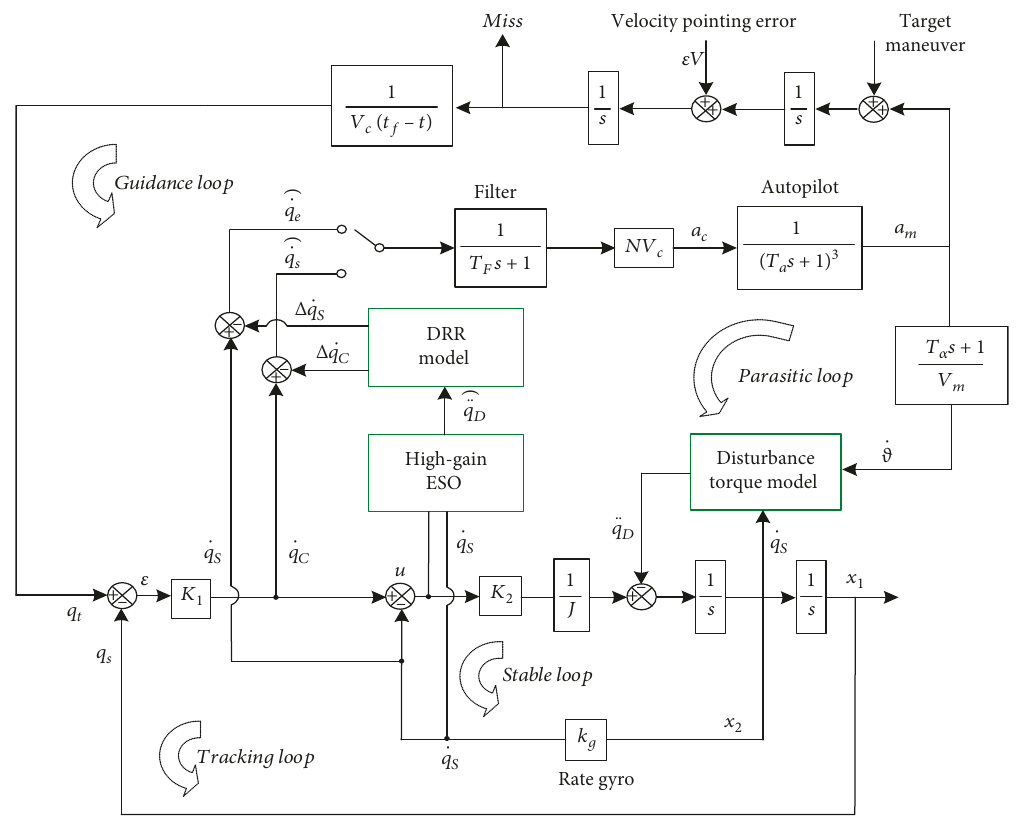
Figure 13: Block diagram of the missile guidance and control system.